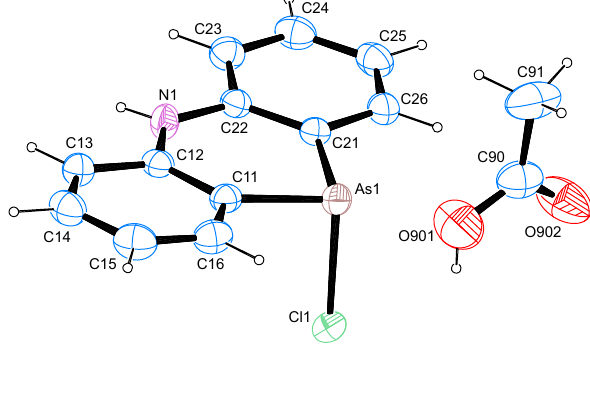
Table  : Data collection and